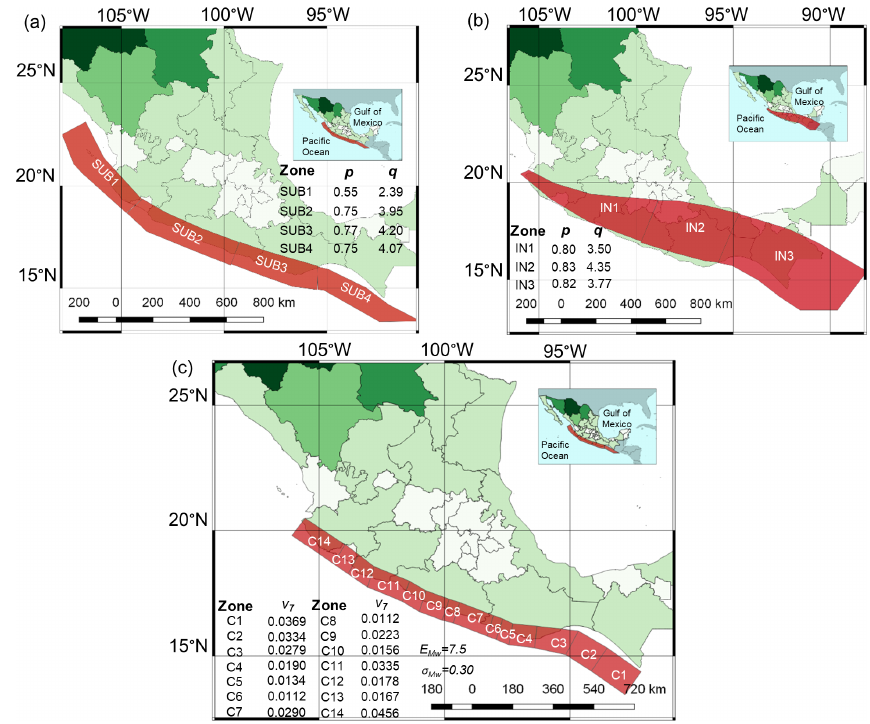
Figure 2. (a) Interplate seismicity regions, (b) intraslab seismicity regions and (c) characteristic seismicity regions.